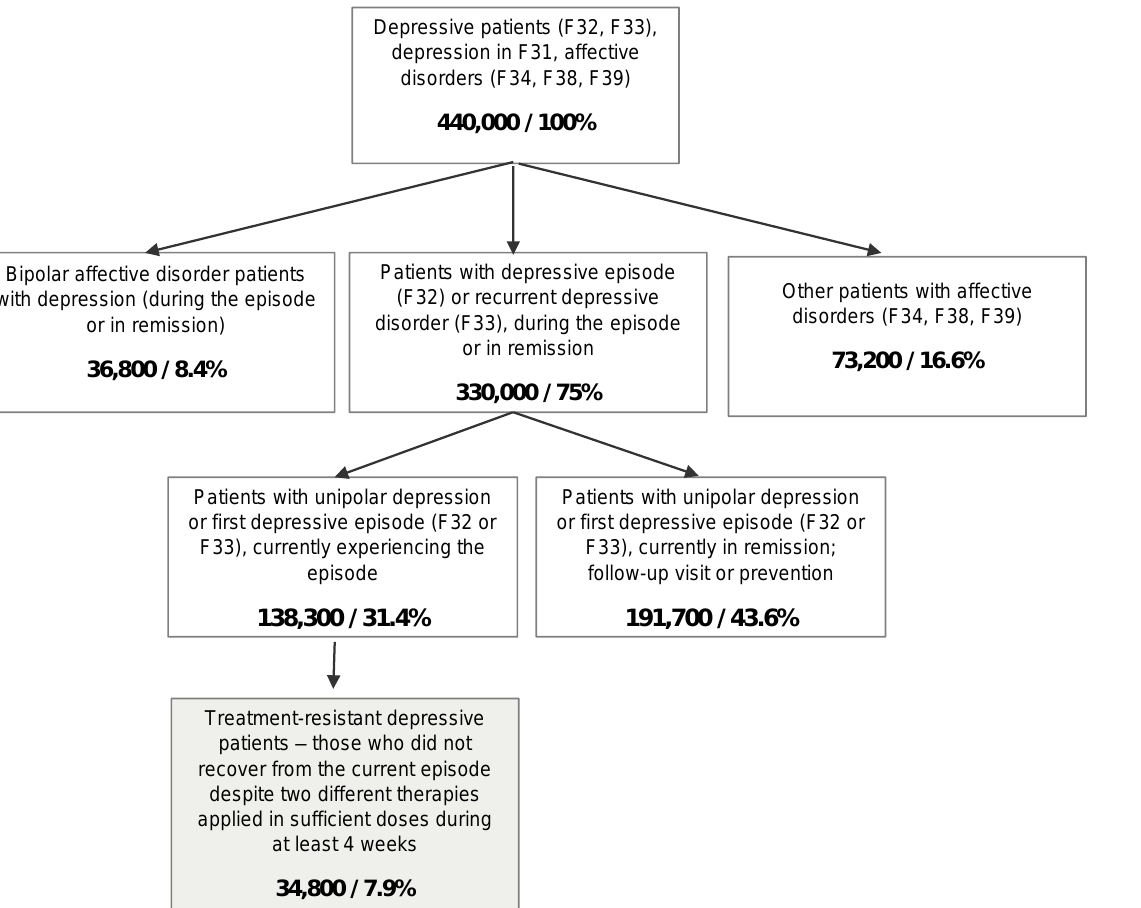
Figure 1. Estimated population sizes of different groups of depressive patients in Poland; percentages represent proportions of the total sample.